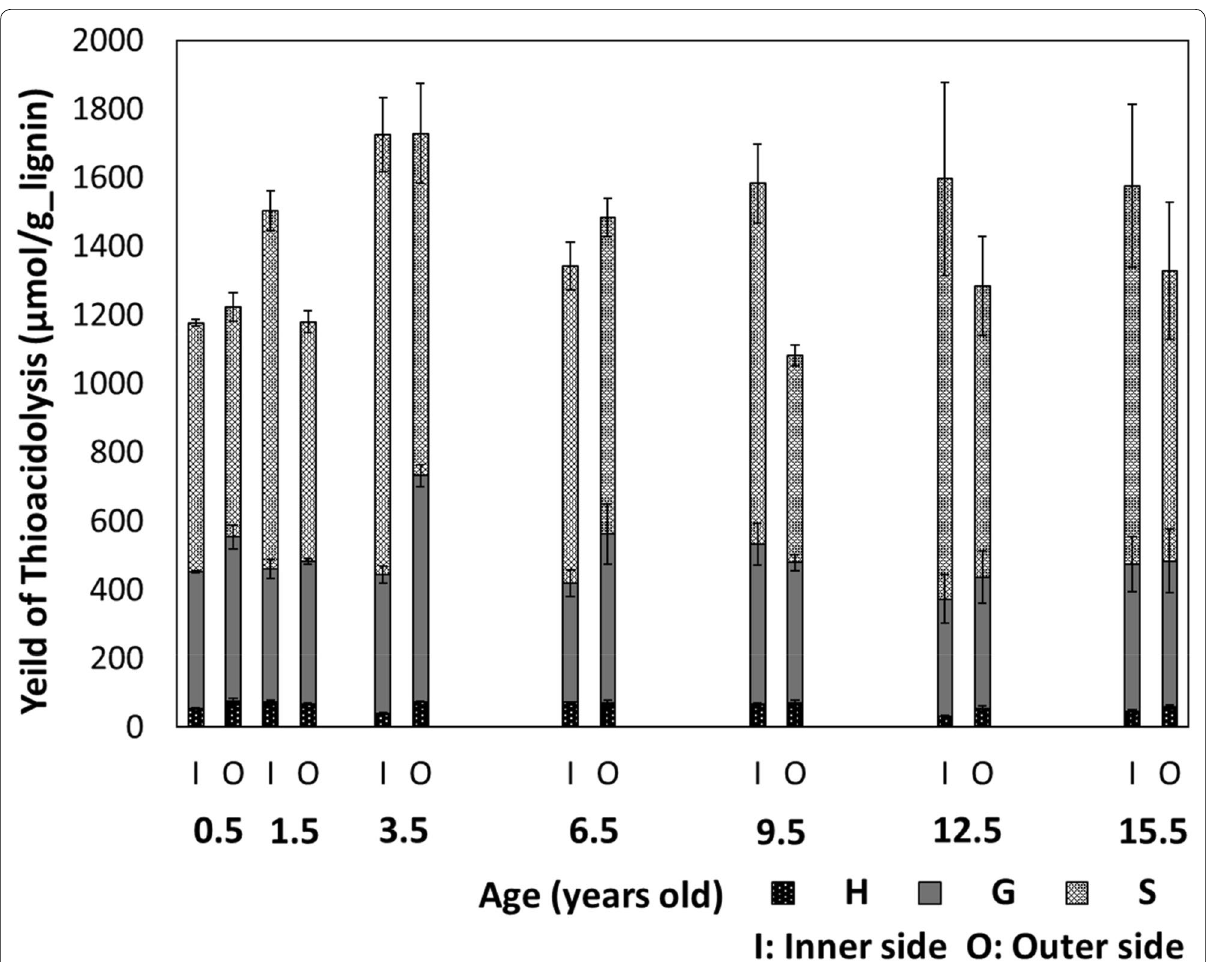
Fig. 6 Lignin-derived H, G, and S monomers released by the thioacidolysis of bamboo samples and total thioacidolysis yield, calculated in micromole of monomers per gram of thioglycolic acid lignin